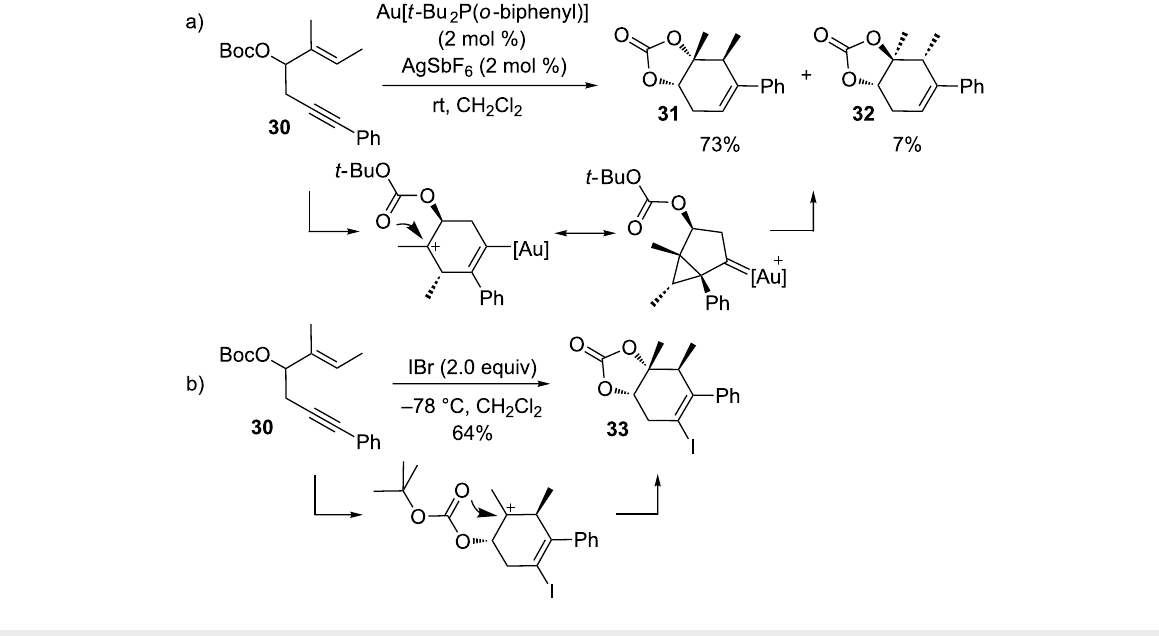
Scheme 10: Reactivity of 3-BocO-1,5-enynes.